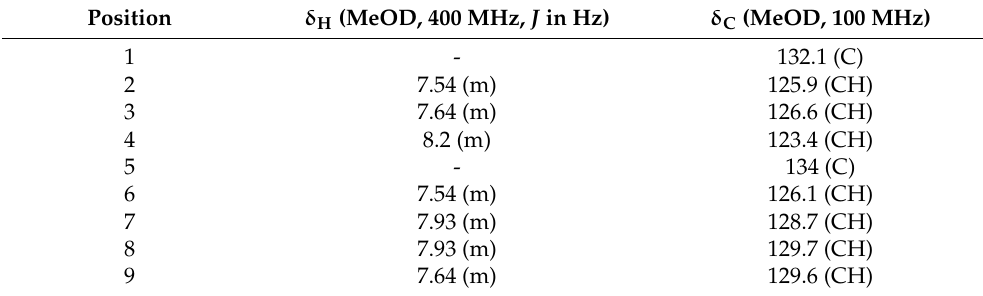
Table 4. 1 H NMR and 13 C NMR data of the pure metabolite in ppm (multiplicity, J in Hz) a